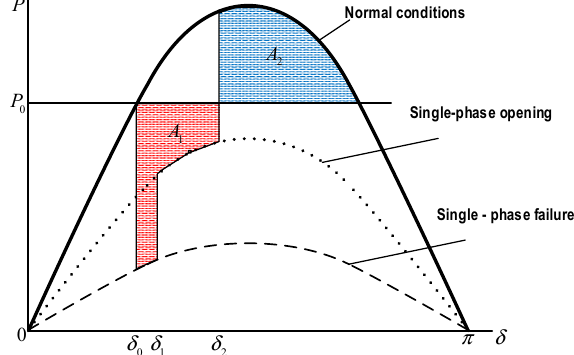
Figure 2. Effect of a single-phase opening and reclosing using the same area criteria.